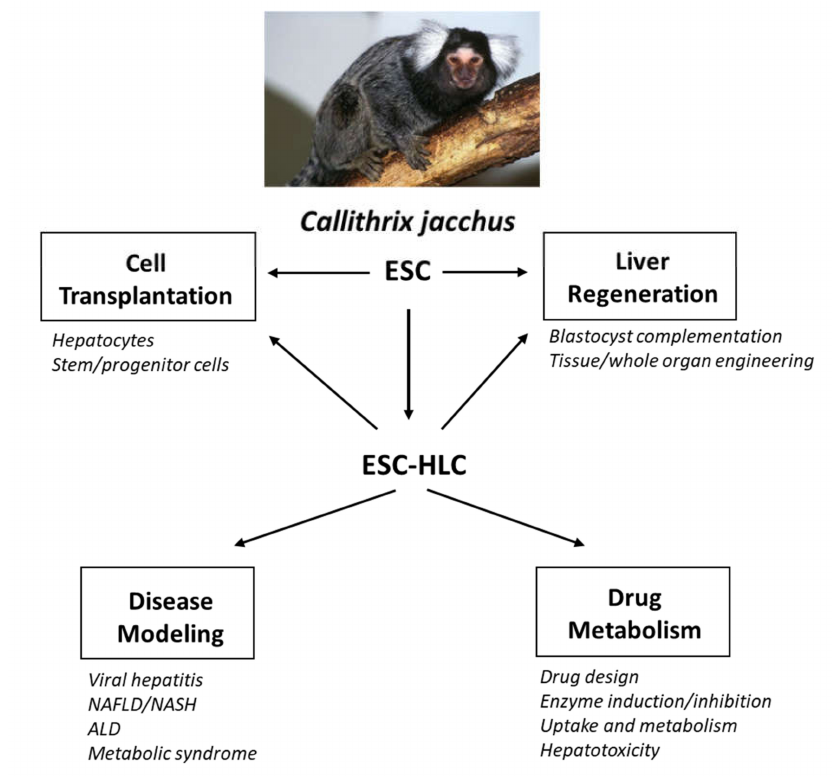
Figure 1. Potential uses for C. jacchus ESC and ESC-HLC in liver